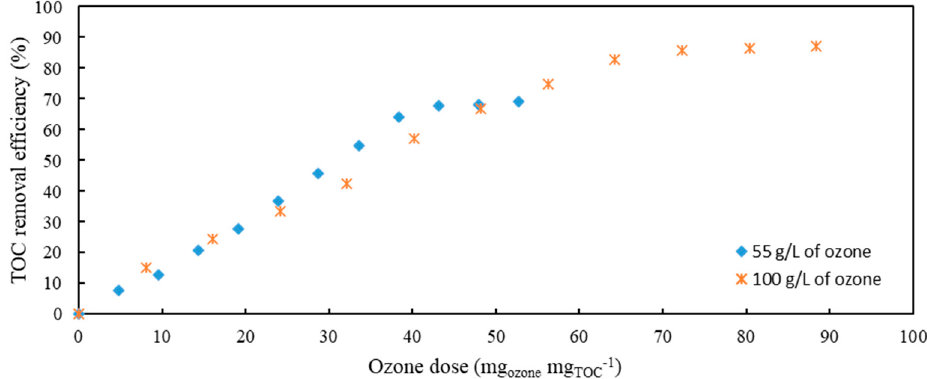
Figure 3. Comparison of different concentrations of ozone for ozonation of model wastewater containing AMX and CIP.